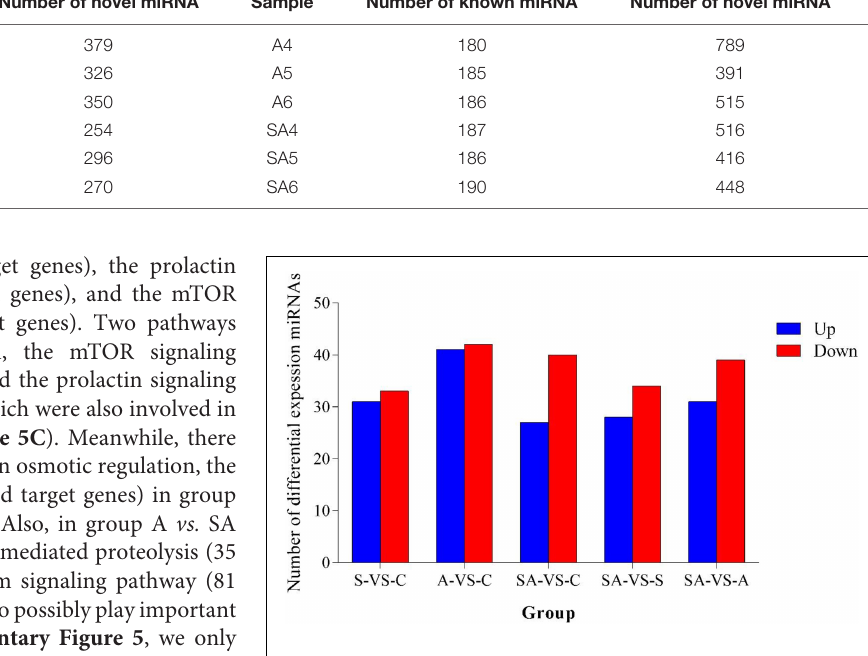
FIGURE 2 | Number of differentially expressed miRNAs in different groups.